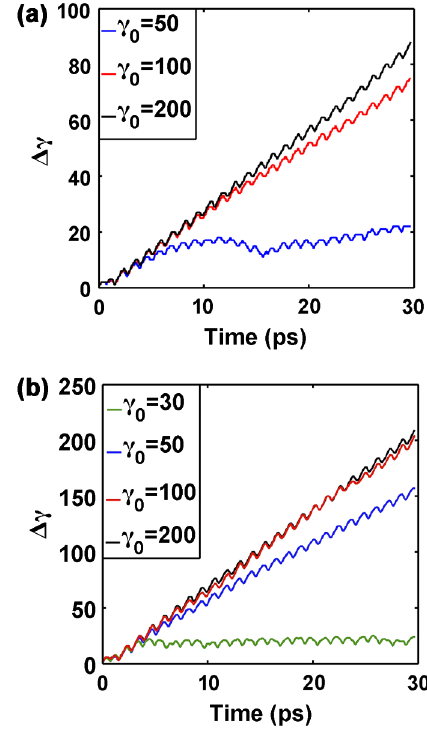
.FIG. 3. Energy gain as a function of acceleration time for different initial electron energies. Here the modulation period is equal to the dephasing length. (a) (cid:1) 0 ¼ 50 , 100, and 200